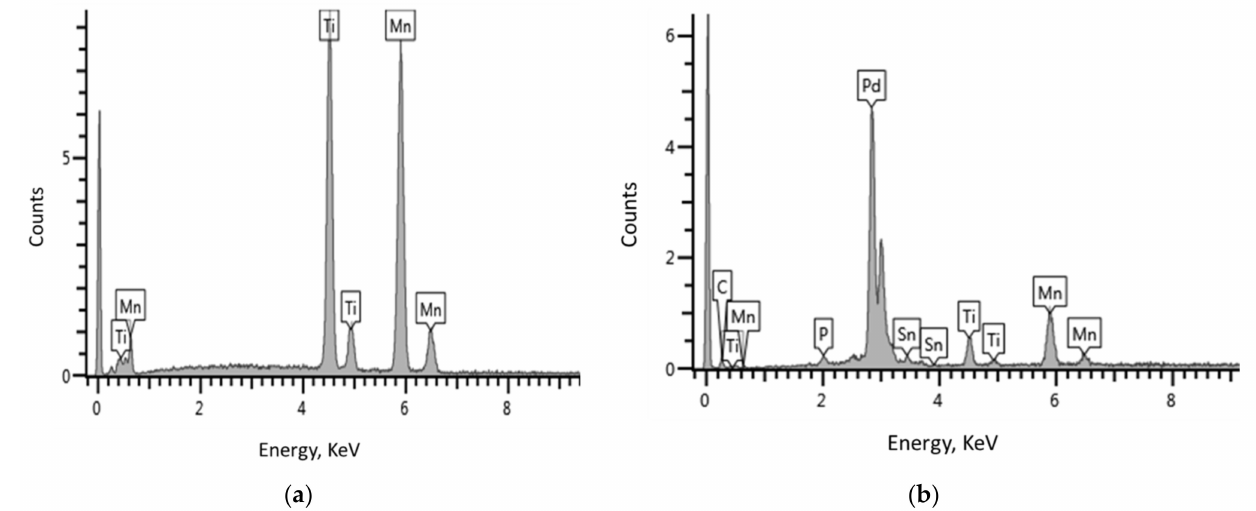
Figure 3. Energy dispersive spectroscopy (EDS) plots of ( a ) TiMn 1.52 and ( b ) Pd–TiMn 1.52 .